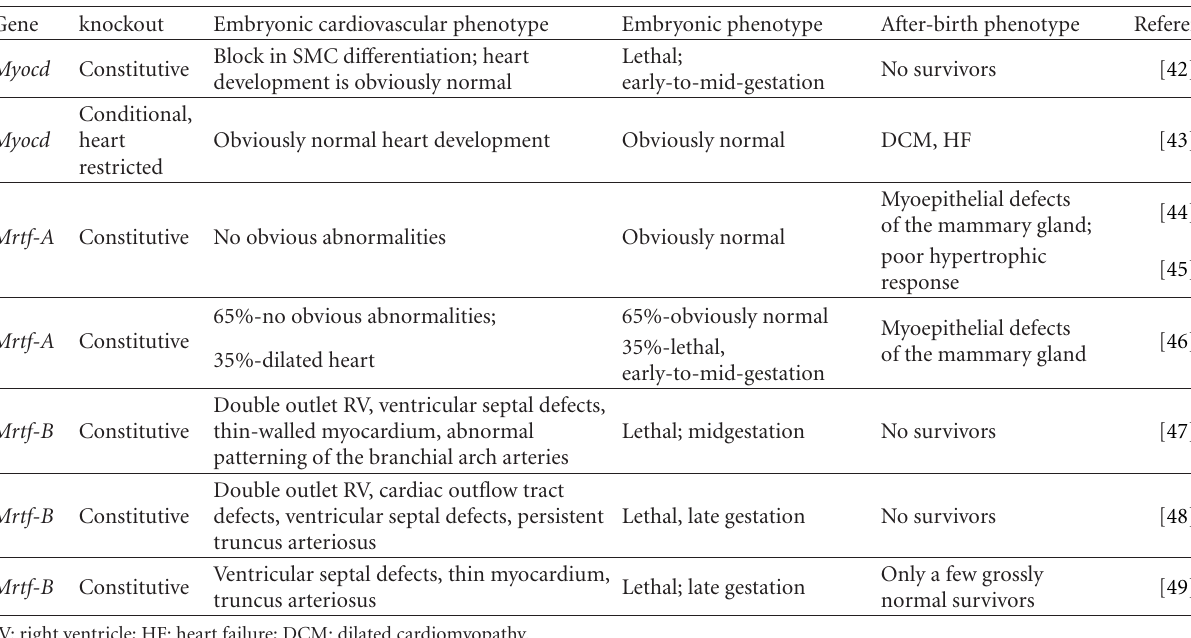
Table 1: Mouse loss-of-function studies of Myocd -related family.